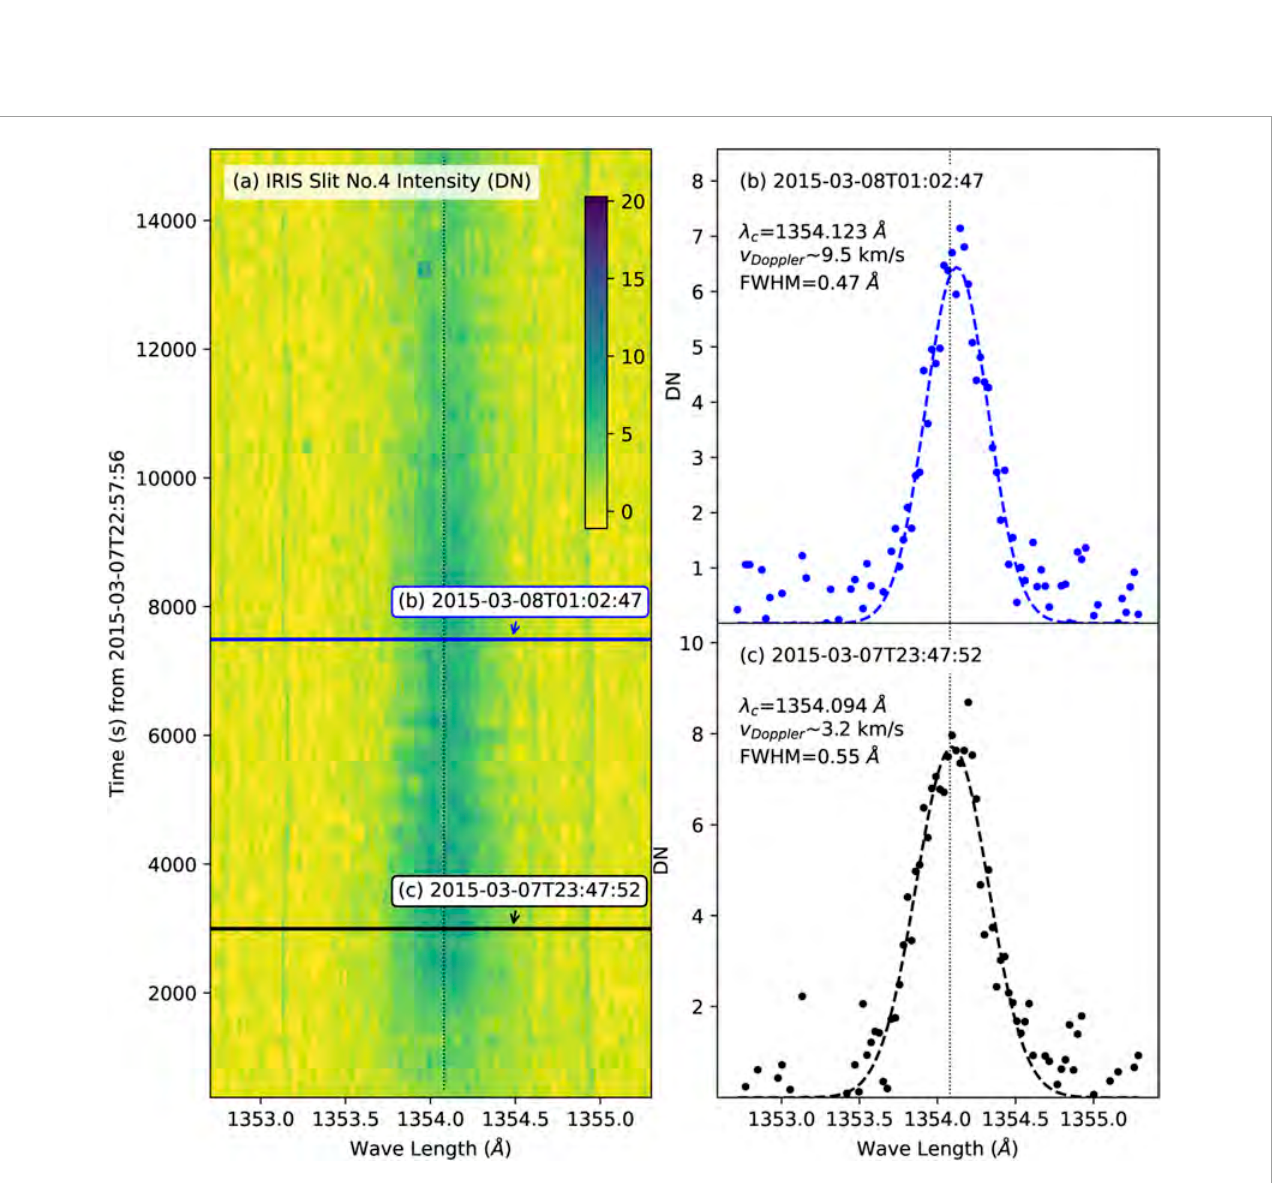
FIGURE 3 Fe XXI observations from IRIS during the 2015–03-07 flare. Panel (A) is the 2D spectral map as a function of time observed by IRIS slit No. 4. Panels (B–C) show Fe XXI spectral profiles at the chosen times indicated by blue and black lines in panel (A) . The dashed curves show Gaussian fitting results with fit parameters (the central wavelength ( λ c ) and FWHM). The vertical dotted lines indicate the position of λ 0 = 1354 . 08